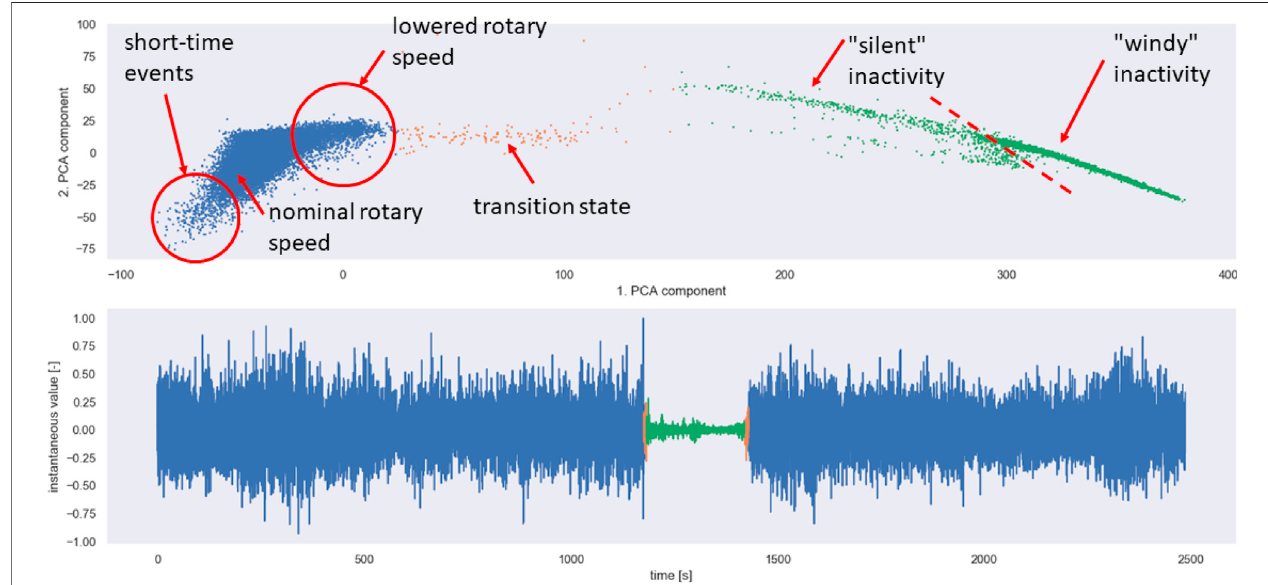
FIGURE 11 | Illustration of wind turbine activity states in time course and parameter space, example of modeling the probability distribution of point placement based on its membership in a given class for operation under normal conditions, continuous operation, signals from the acoustic intensity probe.